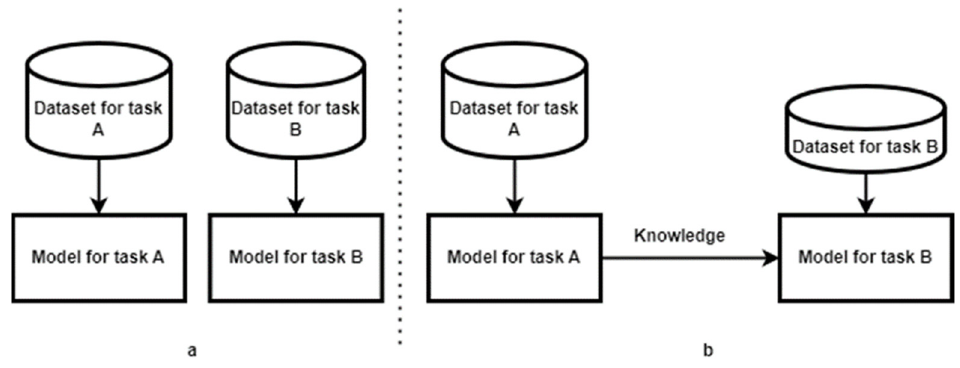
Figure 1. ( a ) Traditional deep learning model ( b ) Transfer learning-based deep learning model.